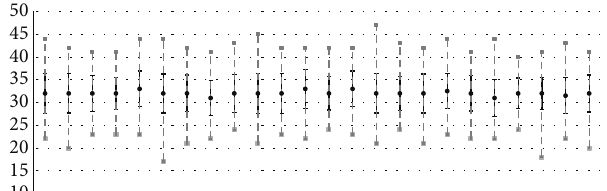
Figure 2: Avalanche analysis of generated